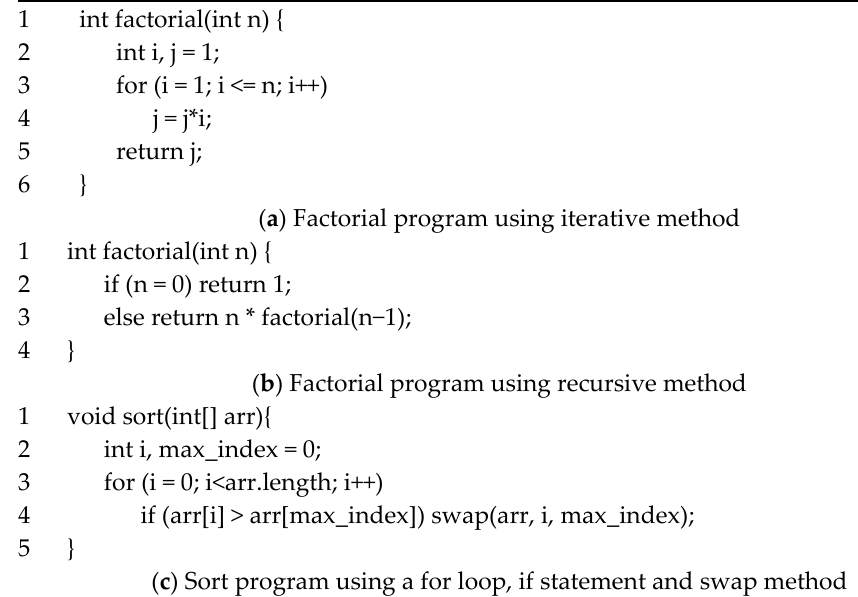
Figure 3. Example code fragments of a T4 type and non-clone type.